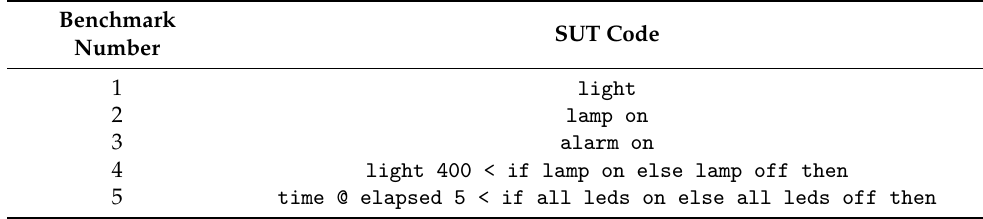
Table 3. Benchmark SUT number and the respective code.